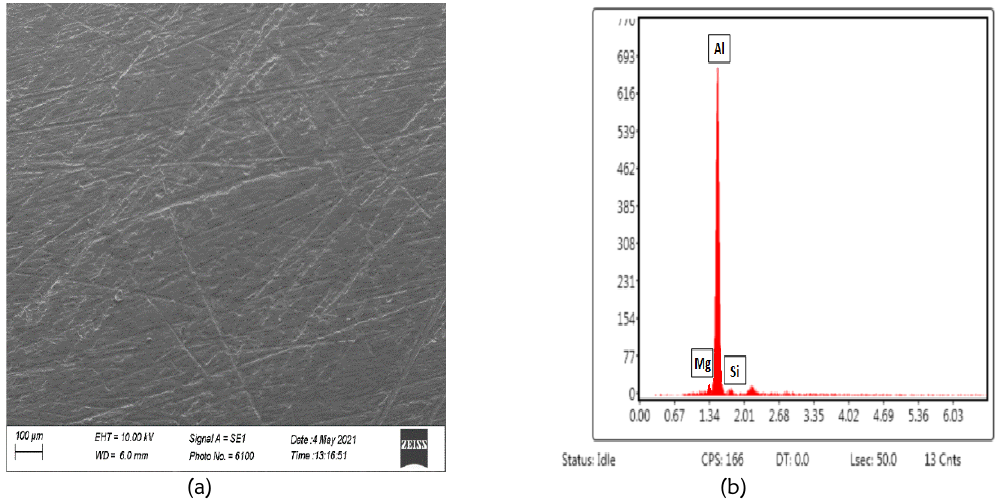
Figure 2: (a) SEM micrograph and (b) EDS of as-cast AA6061